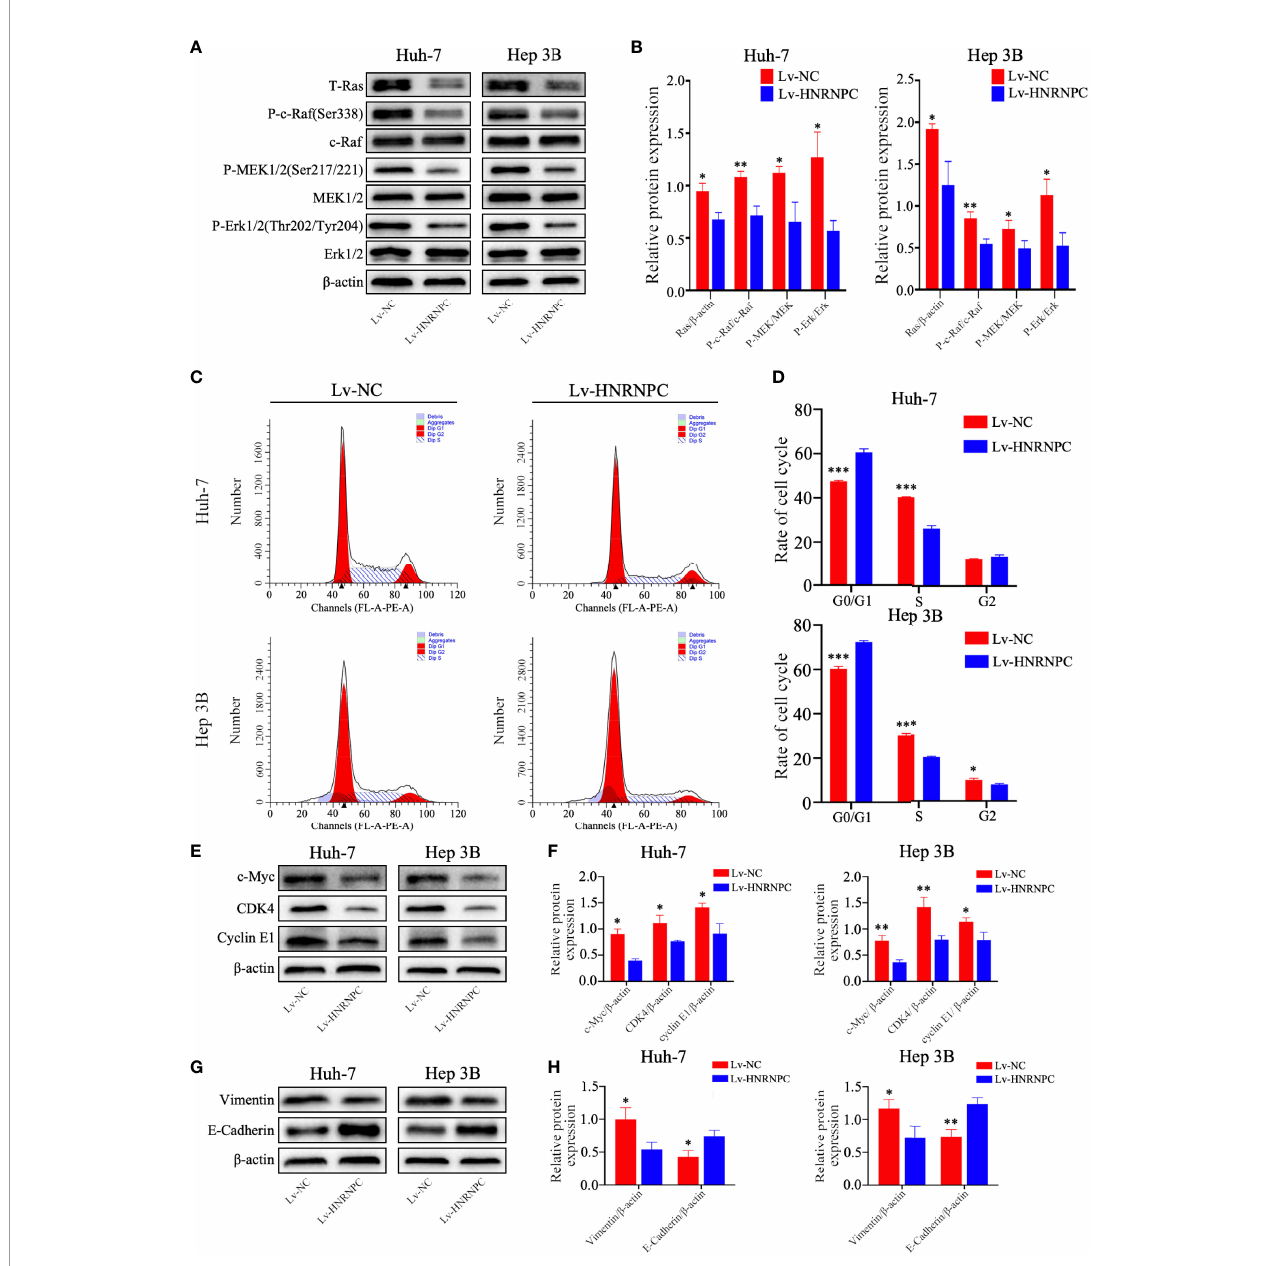
FIGURE 3 | HNRNPC suppression inhibited the Ras/MAPK signaling pathway, leading to arrest of more cells at S phase and blocking of EMT in vitro . (A, B) Western blot to detect activation of the Ras/MAPK signaling pathway in Lv-NC Huh-7, Lv-HNRNPC Huh-7, Lv-NC Hep 3B, and Lv-HNRNPC Hep 3B cells. (C, D) Cell cycle analysis for the various cell groups mentioned above. (E, F) Western blot to detect c-Myc, CDK4, and cyclin E1 levels in the various cell groups. (G, H) Western blot to analyze Vimentin and E-Cadherin expression in various cell groups. Each test was performed independently in triplicate, and the results were presented as mean ± standard deviation (SD). *P < 0.05, **P < 0.01, ***P <